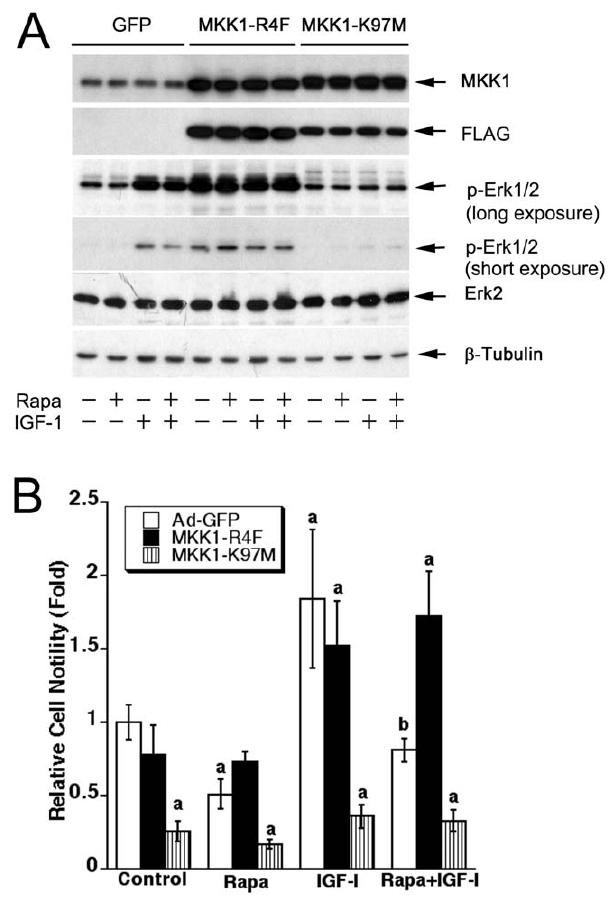
Figure 6. Expression of constitutively active MKK1 confers resistance to rapamycin inhibition of cell motility. (A) Rh30 cells, infected with Ad-MKK1-R4F, Ad-MKK1-K97M, and Ad-GFP (control), respectively, were serum-starved for 24 h, pretreated with or without rapamycin (Rapa, 100 ng/ml) for 2 h, and then stimulated with or without IGF-1 (10 ng/ml) for 15 min, followed by Western blotting with indicated antibodies. (B) Motility of Rh30 cells infected with Ad-MKK1- R4F, Ad-MKK1-K97M or Ad-GFP was determined by the wound healing assay. Results are means 6 SE of 3–4 independent experiments. a P , 0.05, difference vs. Ad-GFP control group; b P , 0.05, difference vs. IGF-1 group.